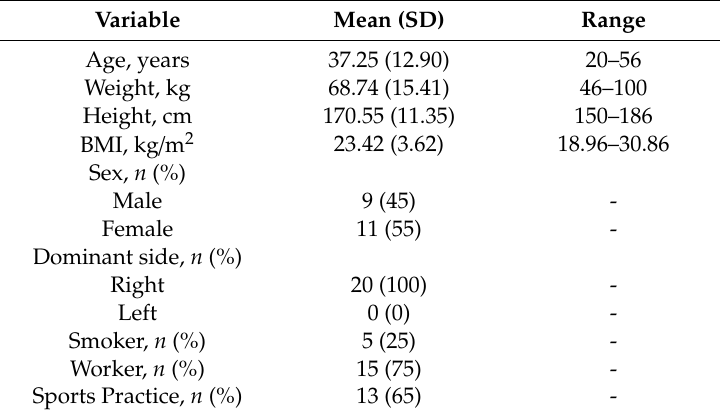
Table 1. Demographic characteristics of volunteers ( n = 20).